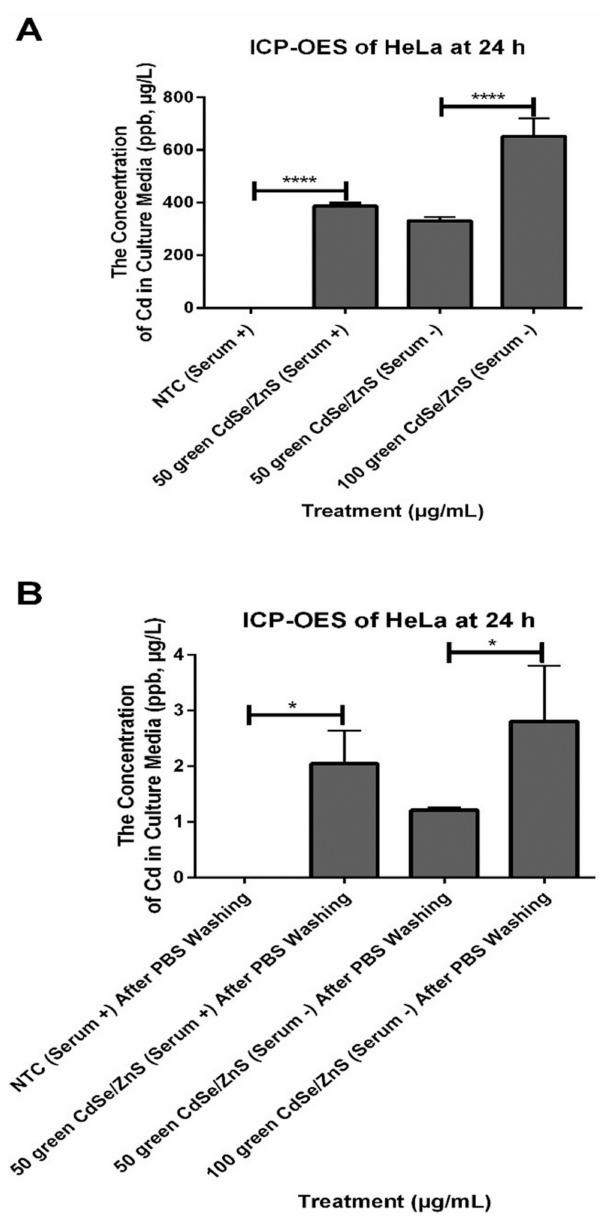
Figure 12. The concentration of secreted QDs by ML-1 and HeLa cells treated with 50 and 100 µ g/mL green CdSe/ZnS in serum+ and − mediums for 24 h. ( A ) The concentration QDs in the culture media of HeLa that were treated with 50 and 100 µ g/mL green CdSe/ZnS QDs in serum+ and − mediums at 24 h. ( B ) The concentration of secreted QDs by HeLa that were treated with 50 and 100 µ g/mL green CdSe/ZnS QDs in serum+ and − mediums at 24 h. Statistically significant results are indicated based on p -values: * = p < 0.05, **** = p <